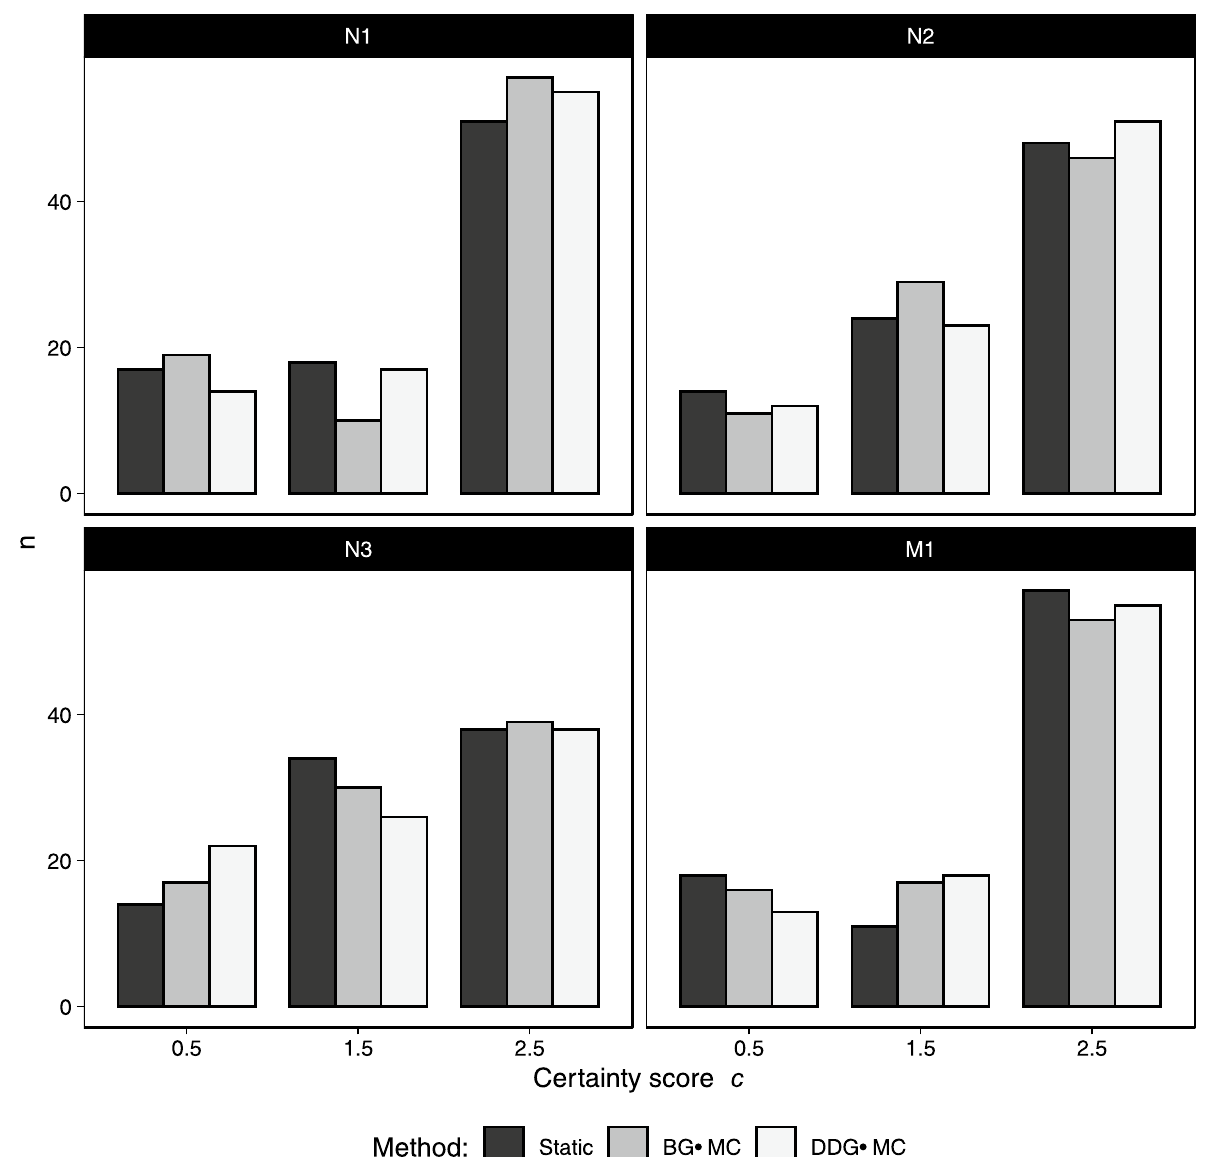
Fig. 4 Distribution of certainty c for N1 to N3 by image reconstruction method summed for both readers (N